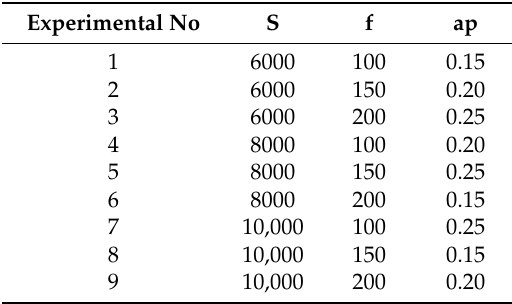
Table 4. The experimental layout using an L 9 orthogonal